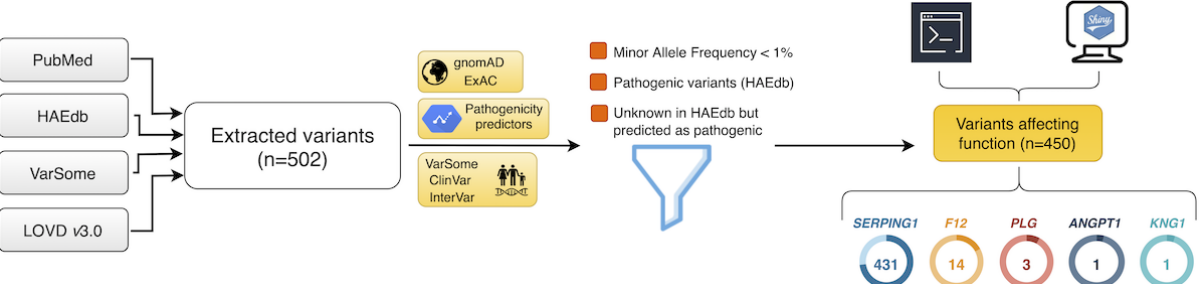
Figure 1. Schematic representation of the steps involved in gene and variant extraction, annotation, and database curation. All genetic variants reported in the articles studying hereditary angioedema (HAE) families in PubMed, HAEdb, VarSome, and the Leiden Open Variation Database (LOVD) were collected (n=502). ANNOVAR was used for annotation of frequencies, pathogenic predictors, and pathogenic classifications, among other information. Variants with a minor allele frequency below 1%, declared as pathogenic in HAEdb or as unknown but with a pathogenic prediction were kept as the set of known variants affecting function